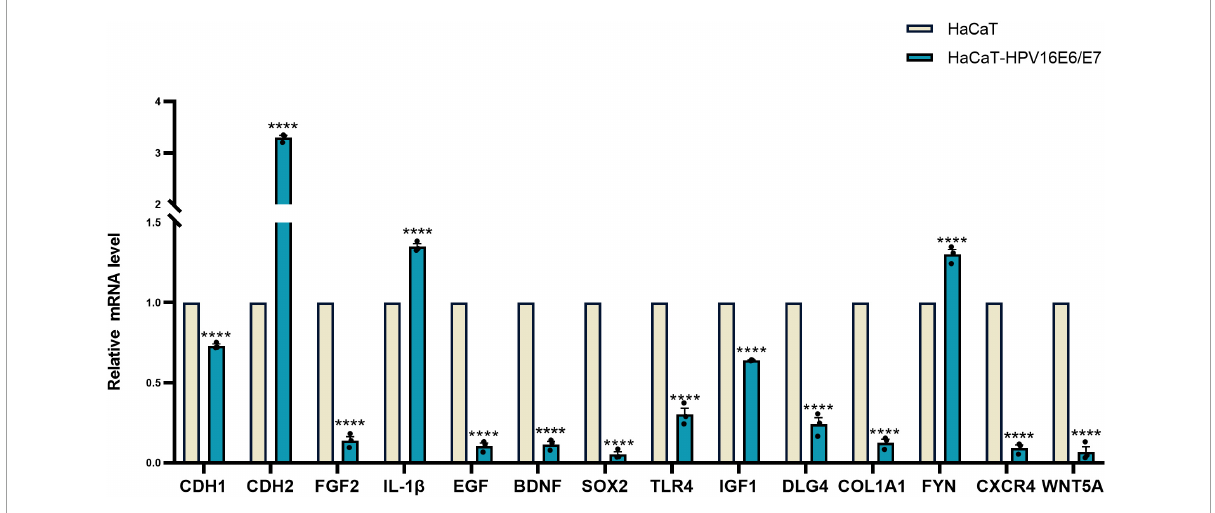
FIGURE7 Verification of 14 hub gene Relative expression results of 14 hub gene were quantified by real-time PCR using GAPDH and β -ACTIN as internal control genes and shown by the bar graph whose horizontal and vertical coordinates represent the gene names and relative expressions, respectively. The verification is consistent with High-throughput sequencing results. **** p <